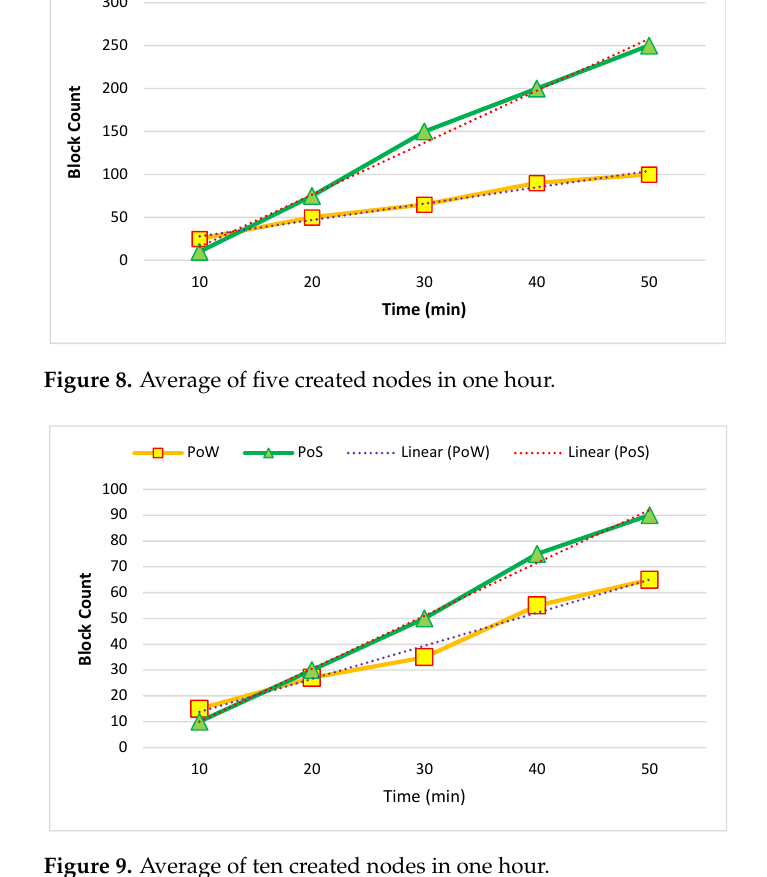
Figure 9. Average of ten created nodes in one hour. Figures 10 and 11 show the comparison of the average mining time of five and ten nodes. The mining time was based on minutes and seconds.